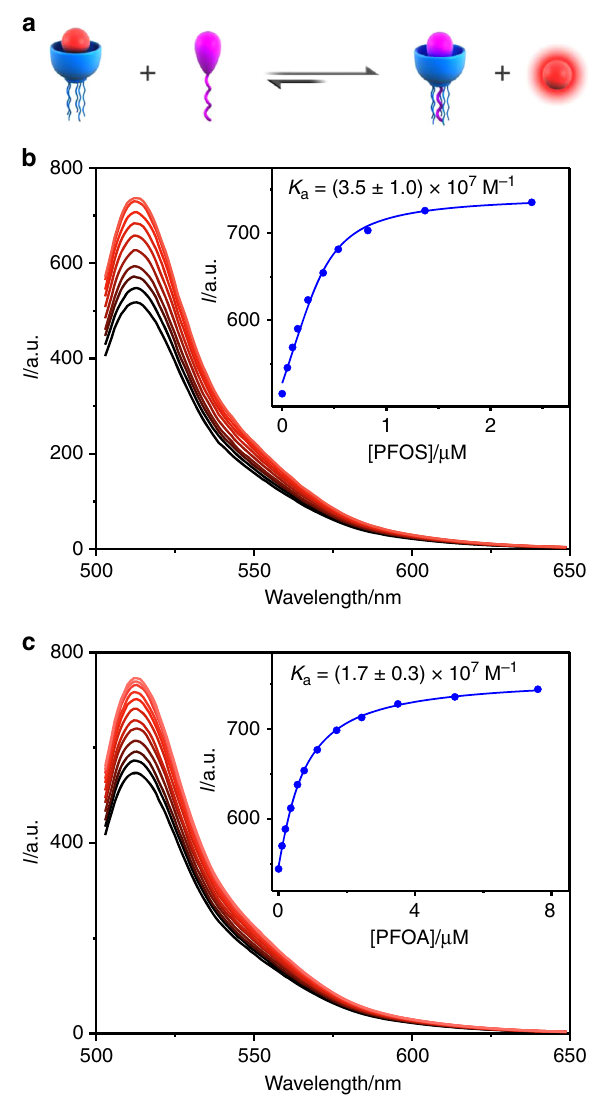
Fig. 3 Illustration of the IDA principle and fl uorescence titrations. a Illustration of the IDA principle. Competitive titrations of GC5A-6C (cid:129) Fl (0.4/0.5 μ M) with b PFOS (up to 2.4 μ M) and c PFOA (up to 7.6 μ M). (Inset) The associated titration curves of b PFOS and c PFOA fi t according to a 1:1 competitive binding model. All experiments were performed in HEPES buffer at 25 °C, λ ex = 500 nm, and λ em = 513 nm. Data represent mean ± s.d. ( n = 3 independent